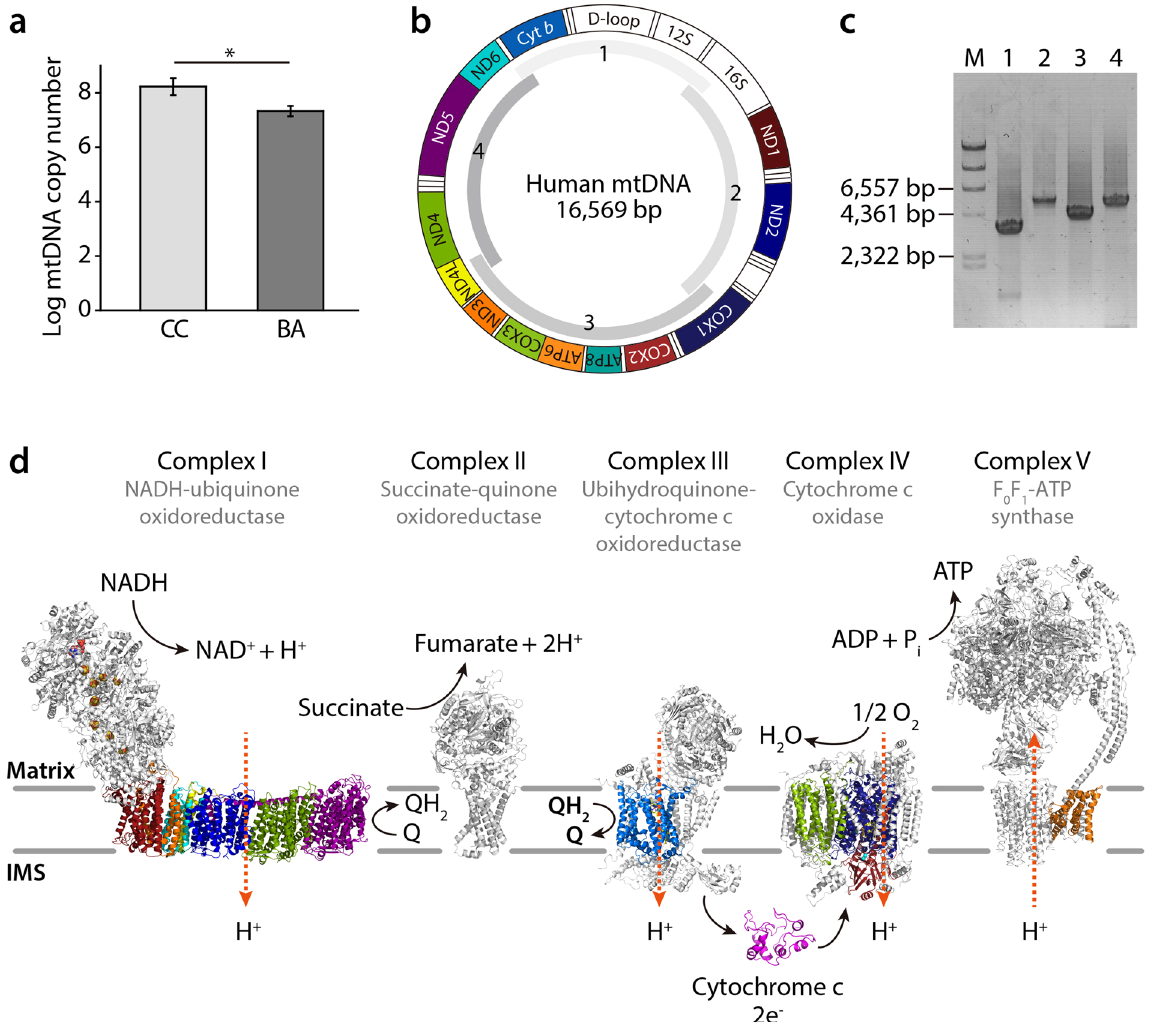
Figure 1. Schematic representation of the human mitochondrial DNA and the mitochondrial respiratory chain. ( a ) Comparison of the mtDNA copy number in plasma between BA and CC patients. The mtDNA copy numbers of CC patient group were slightly higher than those of BA patient group. Data represent the mean ± SE. ∗ p < 0.05 versus BA. ( b ) The map of the human mitochondrial genome (NC_012920.1) with the protein-coding genes colored according to the complexes to which they contribute subunits, two ribosomal RNAs, 22 tRNAs and non-coding D-loop in white. Montage depicting the structural information currently available for the five complexes that together contribute to the mitocondrial oxidative phosphorylation machinery. ( c ) Electrophoresis of the amplified DNA fragments for mtDNA by PCR. M, λ /Hin dIII DNA marker; lane 1, PCR product 1 (3,580 bp); lane 2, PCR product 2 (5,548 bp); lane 3, PCR product 3 (4,447 bp); lane 4, PCR product 4 (5,591 bp). ( d ) The mammalian mitochondrial electron transport chain includes the proton-pumping enzymes complex I (NADH–ubiquinone oxidoreductase), complex III (cytochrome bc 1 ) and complex IV (cytochrome c oxidase), that combined, generate proton motive force that in turn drives F 1 F O - ATP synthase. Each complex is embedded in the lipid bilayer with the mitocondrial-encoded subunits colored corresponding to the genome diagram. The structure of each respiratory complex is presented: complex I from Thermus thermophilus (protein databank (PDB) code 4HEA), complex II from porcine Sus scrofa (PDB 4YXD), complex III from bovine Bos taurus (PDB 1L0L), complex IV from bovine B. taurus (PDB 1OCC) and complex V from bovine B. taurus (PDB 5ARA). The iron-sulfur cofactors of complex I are depicted as orange and yellow spheres. IMS, intermembrane